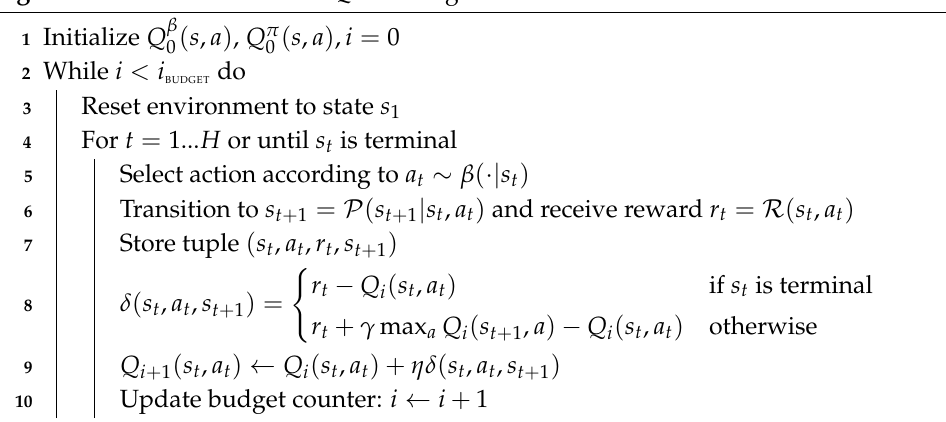
Algorithm A5: Classic Tabular